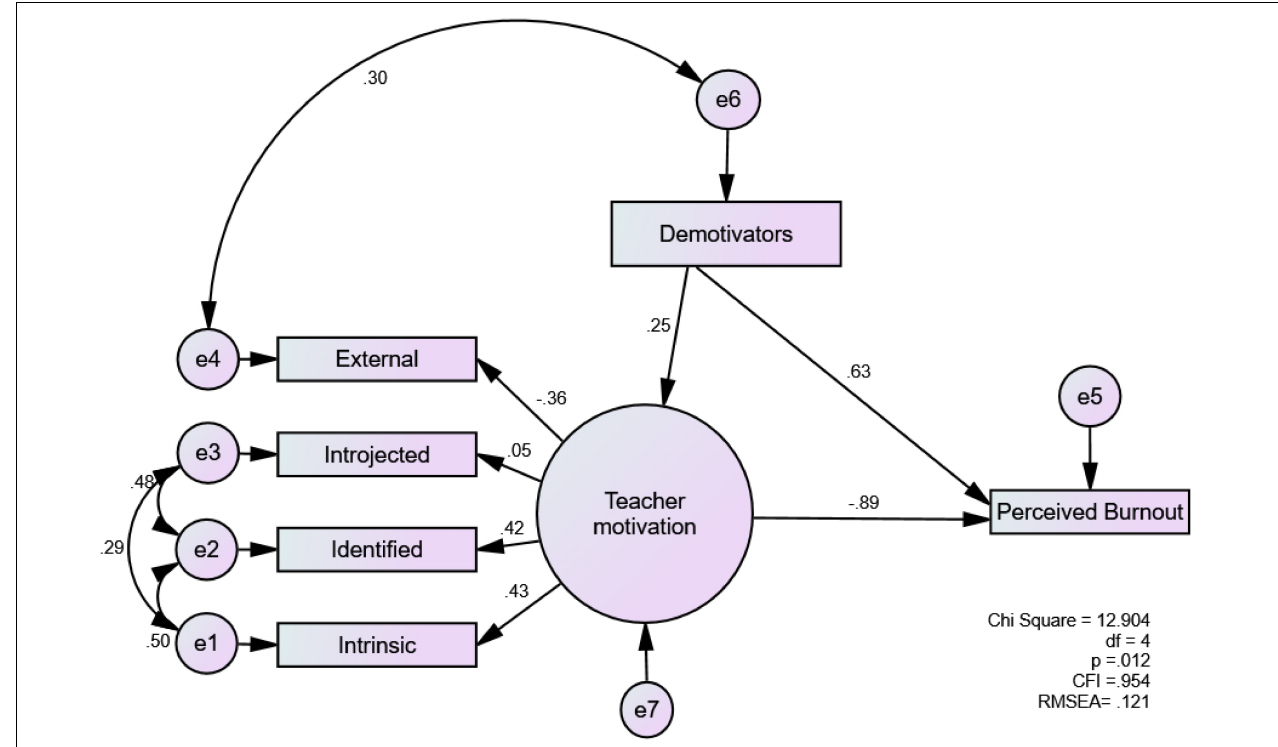
FIGURE 1 | Standardized model of teacher motivation, teacher demotivators, and perceived burnout ( N =